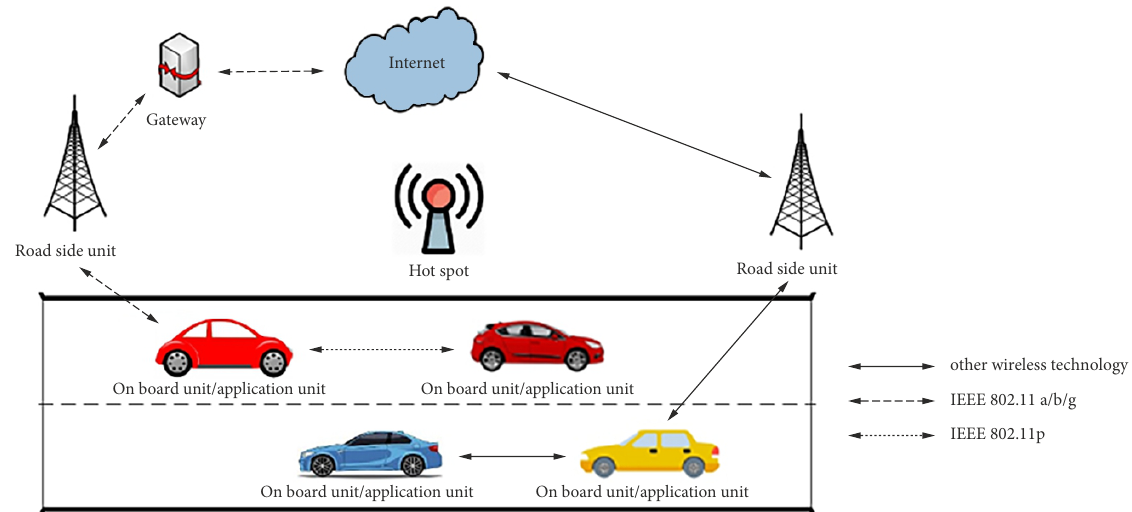
Figure 4. Architecture of